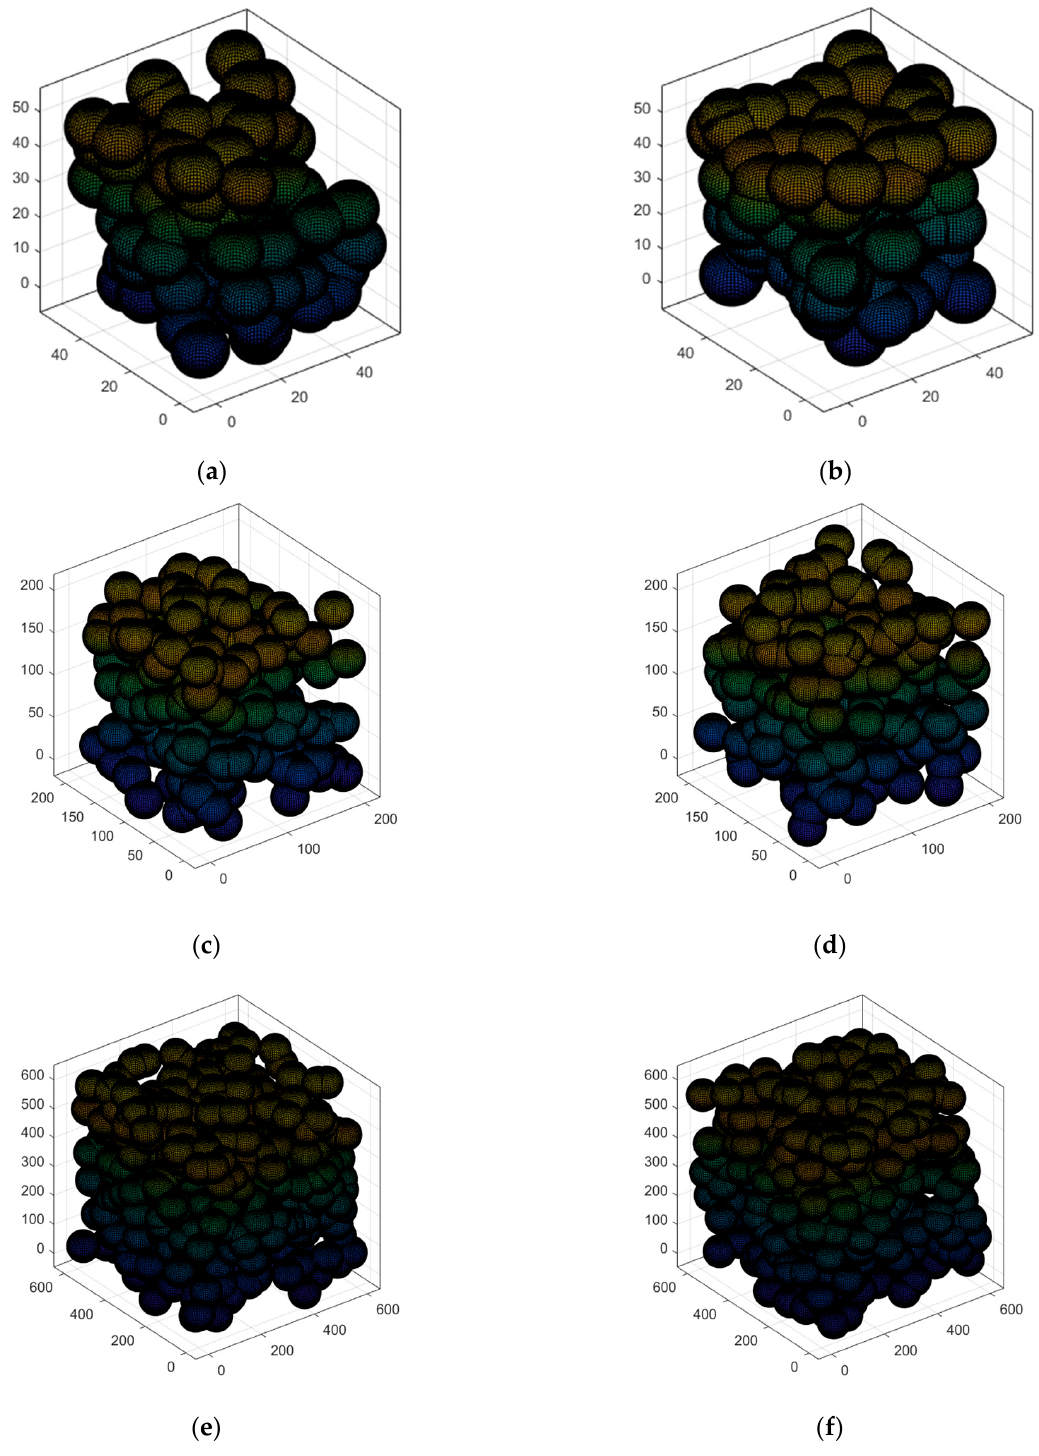
Figure 7. Original and secondary deployment diagrams: ( a ) Random deployment of nodes effect diagram of the small network; ( b ) Highly destructive polynomial mutation strategy effect diagram of the small network; ( c ) Random deployment of nodes effect diagram of the medium-sized network; ( d ) Highly destructive polynomial mutation strategy effect diagram of the medium-sized network; ( e ) Random deployment of nodes effect diagram of the large network; ( f ) Highly destructive polynomial mutation strategy effect diagram of the large network.